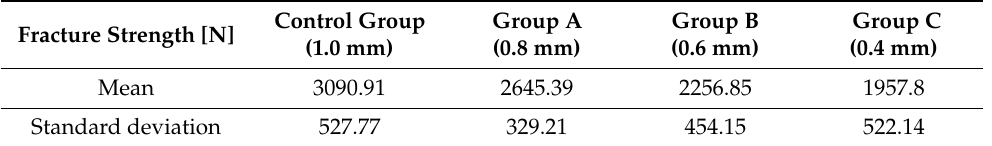
Table 4. Results of the fracture strength